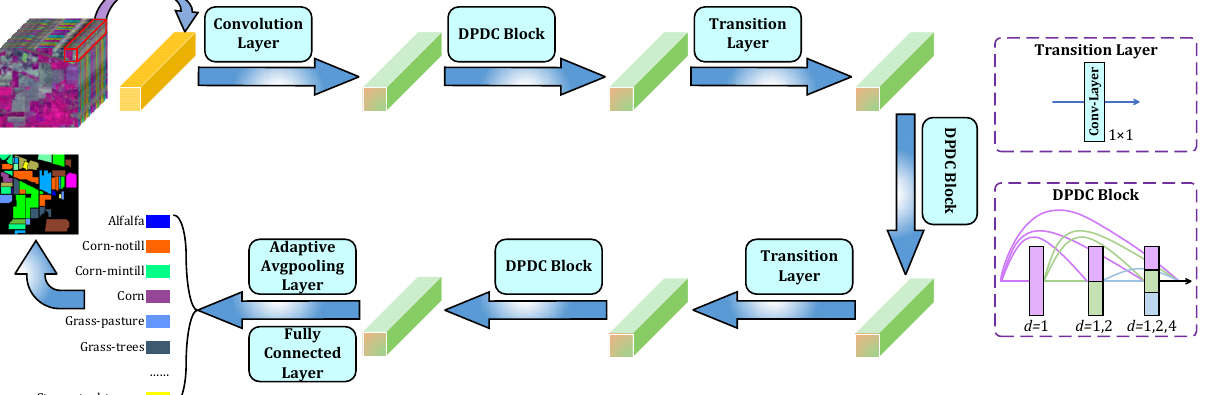
Figure 5. The framework of